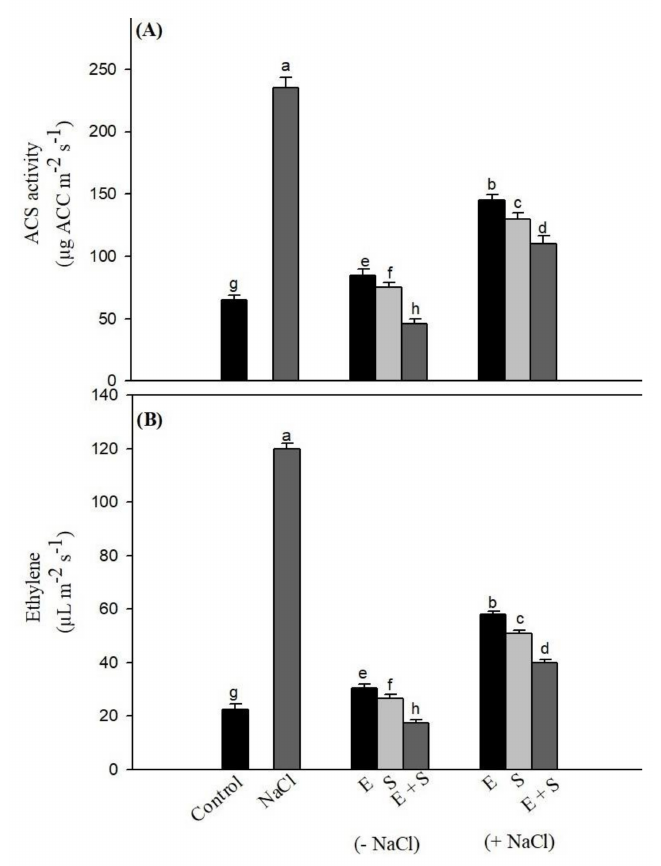
Figure 1. ( A ) Activity of 1-aminocyclopropane carboxylic acid synthase (ACS) and ( B ) ethylene emission in mustard leaves at 30 days after sowing treated with 200 µ L L − 1 ethephon (E) and/or 200 mg S kg − 1 soil (S) in presence or absence of 100 mM NaCl. Data are presented as treatments mean ± SE ( n = 4). Data followed by same letter are not significantly different by LSD test at p <